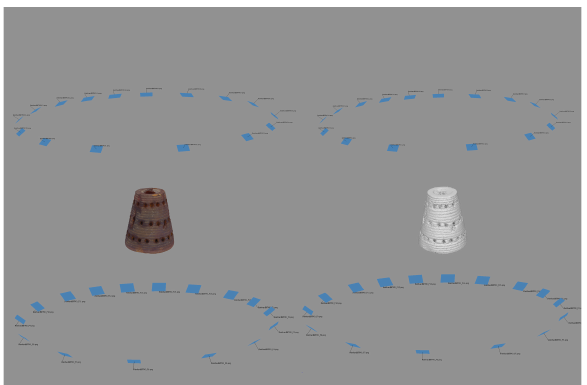
Figure 3. Camera positions related to the object.